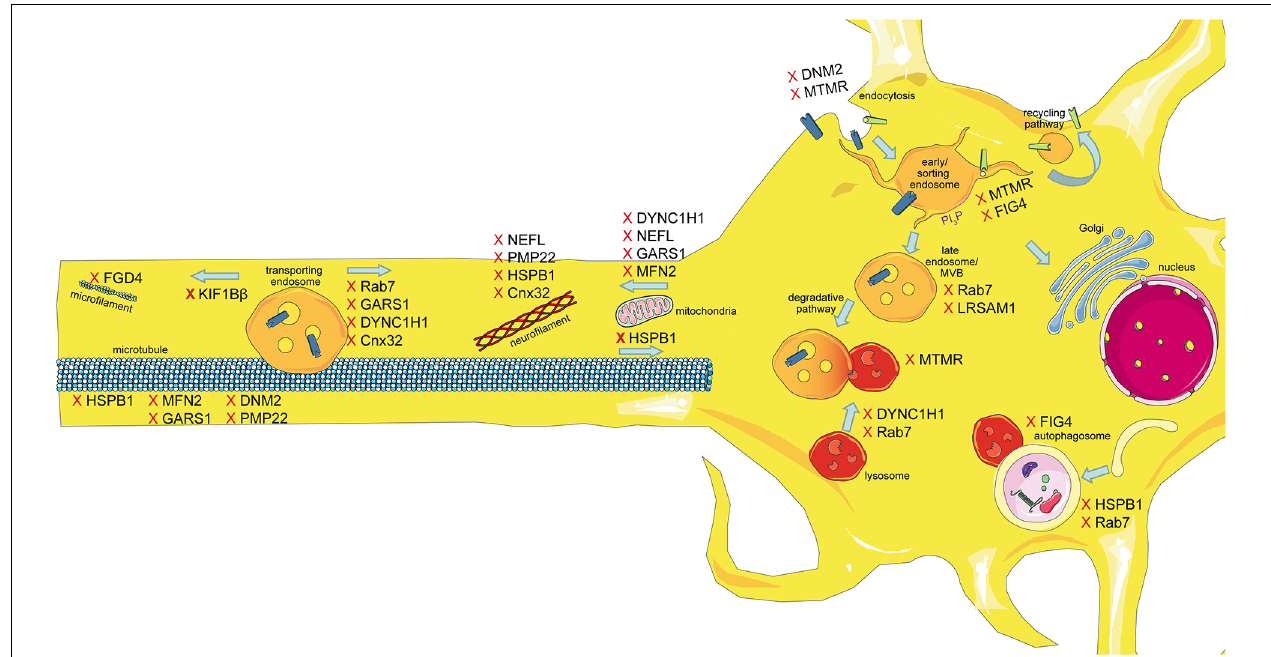
FIGURE 1 | Schematic overview of the intracellular trafficking processes in a neuron of the PNS. Highlighting all the steps where proteins involved in CMT can cause dysregulation. This figure was created using Servier Medical Art templates, which are licensed under a Creative Commons Attribution 3.0 Unported License;